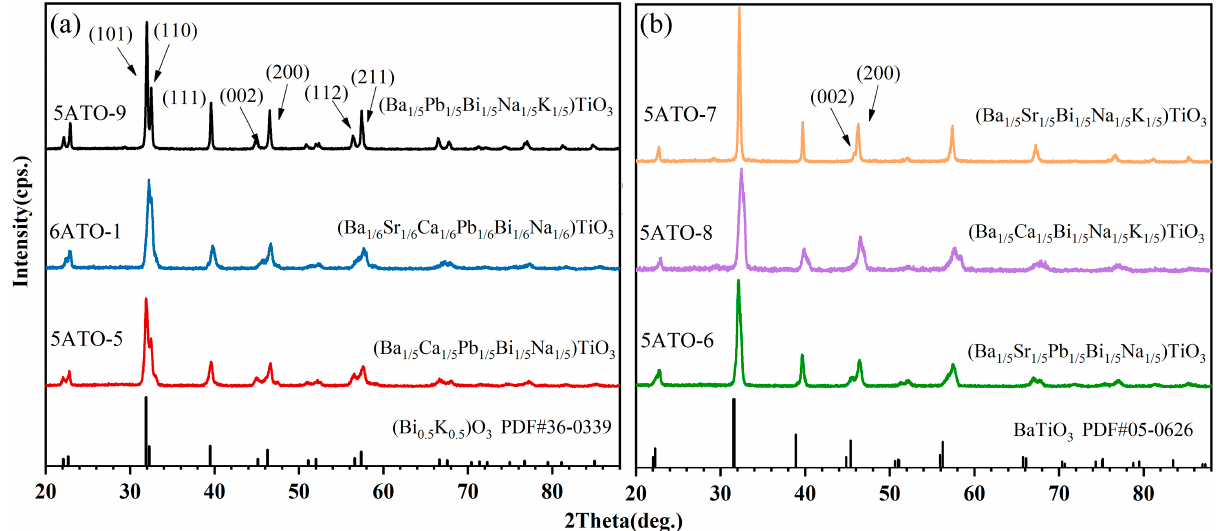
Figure 5. XRD patterns of the six samples which possess tetragonal perovskite structure: ( a ) 5ATO-5, 5ATO-9, and 6ATO-1, ( b ) 5ATO-6, 5ATO-7, and 5ATO-8.